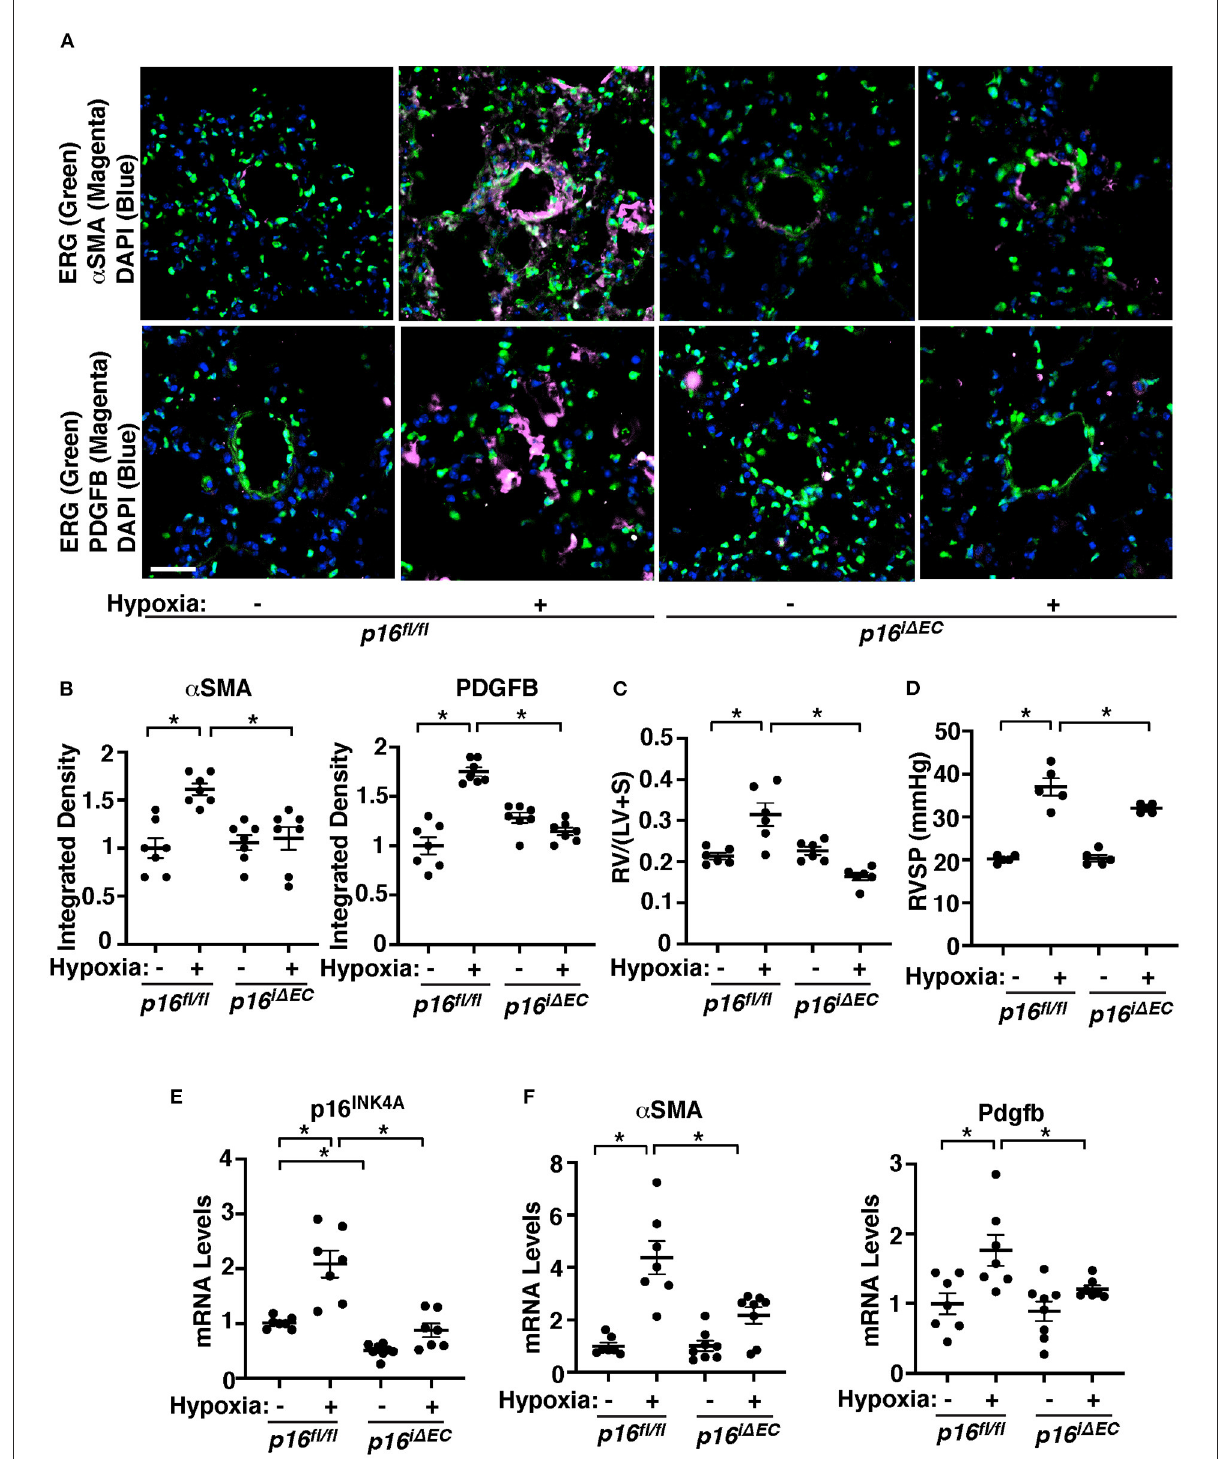
FIGURE2 Endothelial p16 INK4A mediates hypoxia-induced vascular remodeling in pulmonary arterioles in the mouse lung. (A) IF images of representative pulmonary arterioles in the lungs of tamoxifen-induced p16 fl / fl or p16 i 1 EC mice treated with normoxia or hypoxia for 3 weeks stained for α SMA, ERG, and DAPI ( top ) or PDGFB, ERG, and DAPI ( bottom ). Scale bar: 25 µ m. (B) Graphs showing integrated fluorescent density of α SMA and PDGFB in tamoxifen-induced p16 fl / fl or p16 i 1 EC mice treated with normoxia or hypoxia for 3 weeks ( n = 7, mean ± SEM, * p < 0.05). (C)